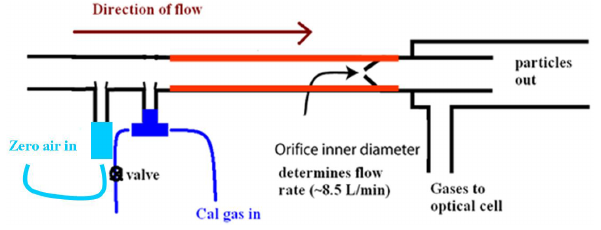
Fig. 3. Schematic of QC-TILDAS quartz inlet outlining the loca- tions of background and calibration ports, critical orifice and virtual impactor. The red lines indicate heating of the inlet to 40 ◦